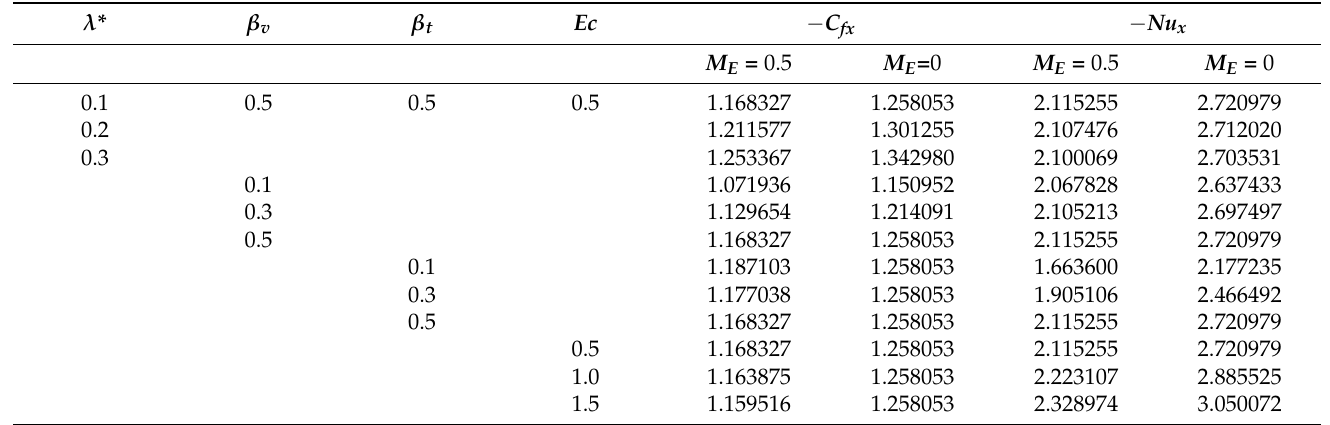
Table 3. Computational values of C fx and Nu x for various dimensionless parameters keeping